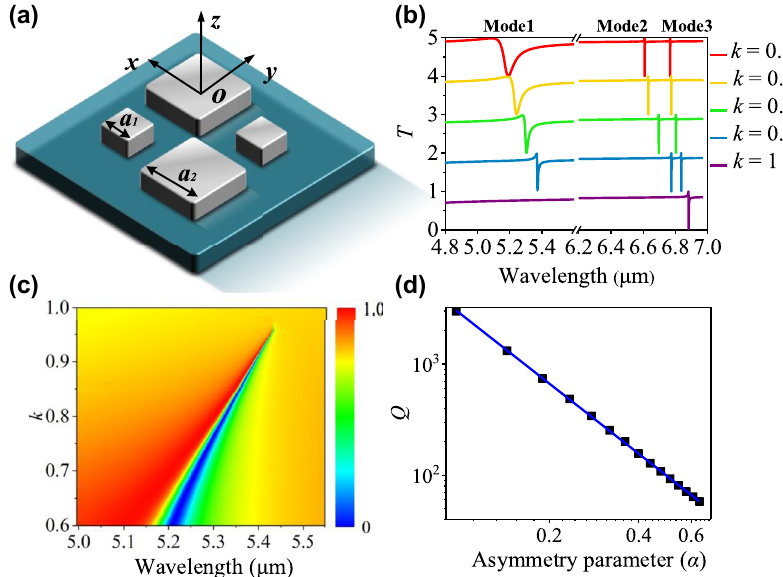
Figure7: Schematicconfigurationandmulti- Fano resonance characteristics of the pro- posed asymmetric metasurface. (a) 3D schematic diagram of the asymmetric meta- surface. (b) The transmission spectra under different linearly scaled factor k. (c) The transmission spectra of Mode 1 under dif- ferent linearly scaled factor k. (d) Q-factors extracted from calculated spectra under different asymmetric parameters of Mode